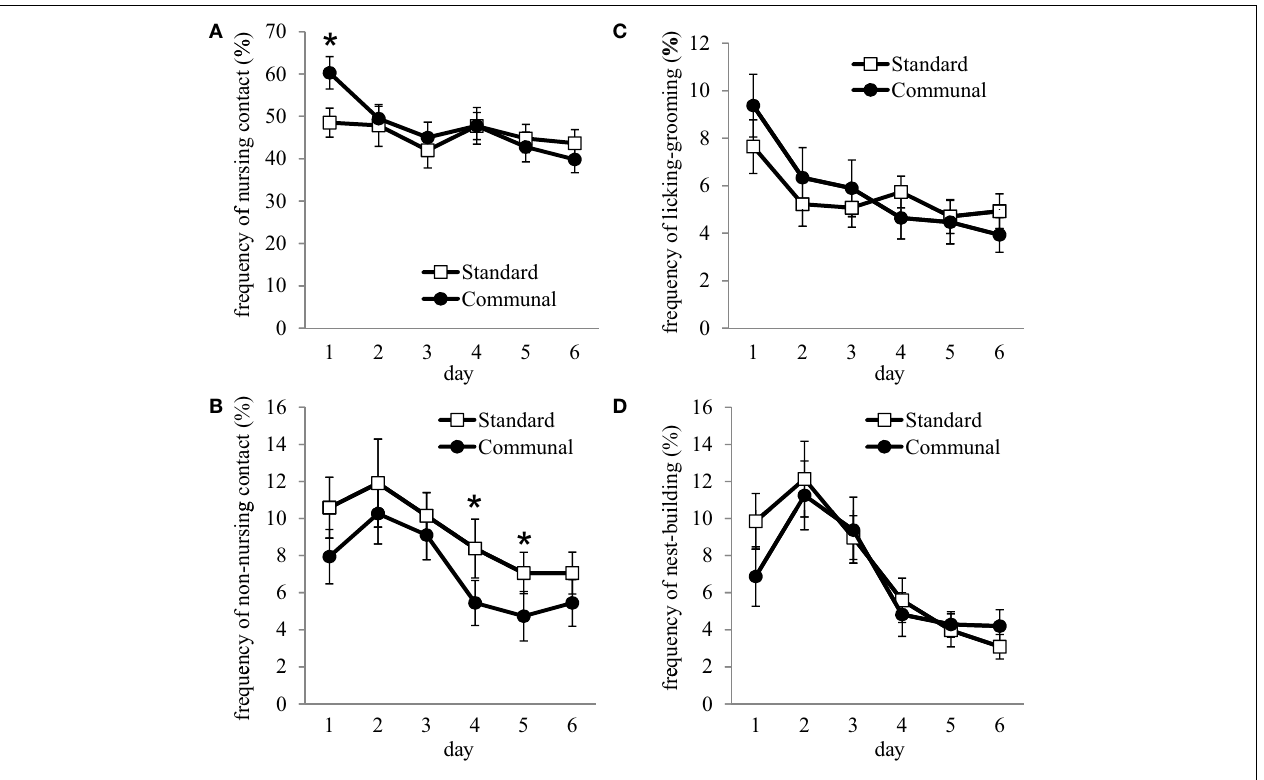
FIGURE 5 | Postpartum maternal behavior amongst F2 standard and communal females. Though frequency of (A) nursing-contact did not signifi cantly vary between groups overall, there were signifi cant elevations in this behavior